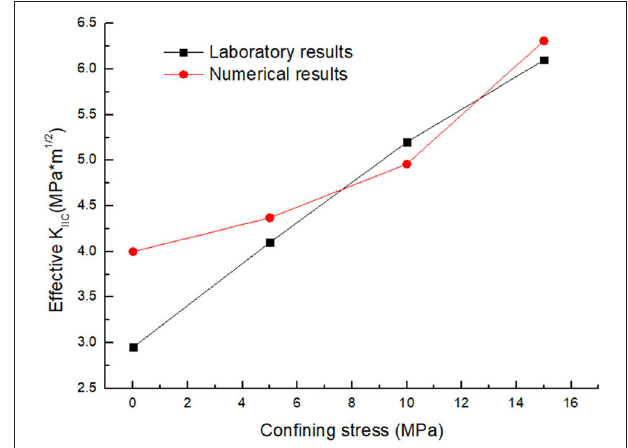
FIGURE 9 | The numerical and laboratory effective shear fracture toughness for various